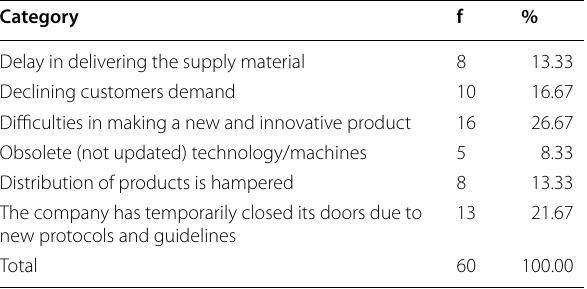
Table 9 Determinants of the problems encountered by the respondents that lead to business failure in terms of the operational aspect